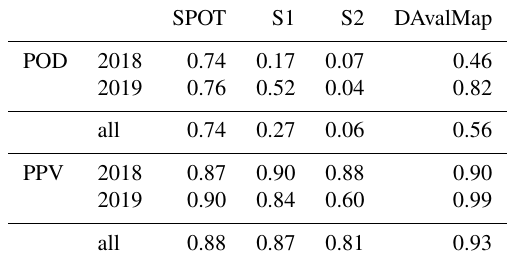
Table 4. POD and PPV of the different methods for the mapping from 2018, 2019 and together.